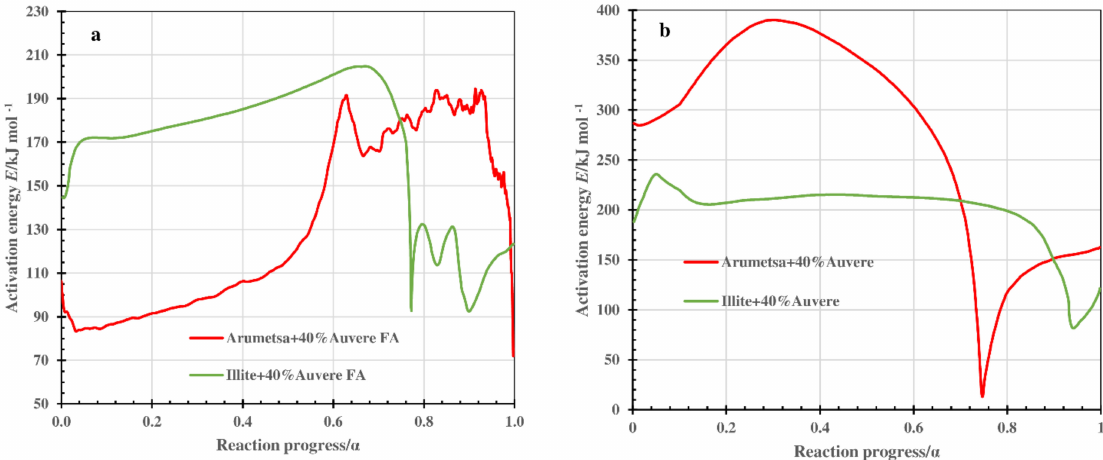
Figure 10. Value of activation energy E determined by Friedman analysis as a function of the conversion degree α for thermooxidative decomposition of Arumetsa and illitic clay with 40% Auvere FA in step I ( a ) and step II ( b ). Table 5. The activation energy E /kJ mol − 1 vs. reaction progress α ( α between 0.1 and